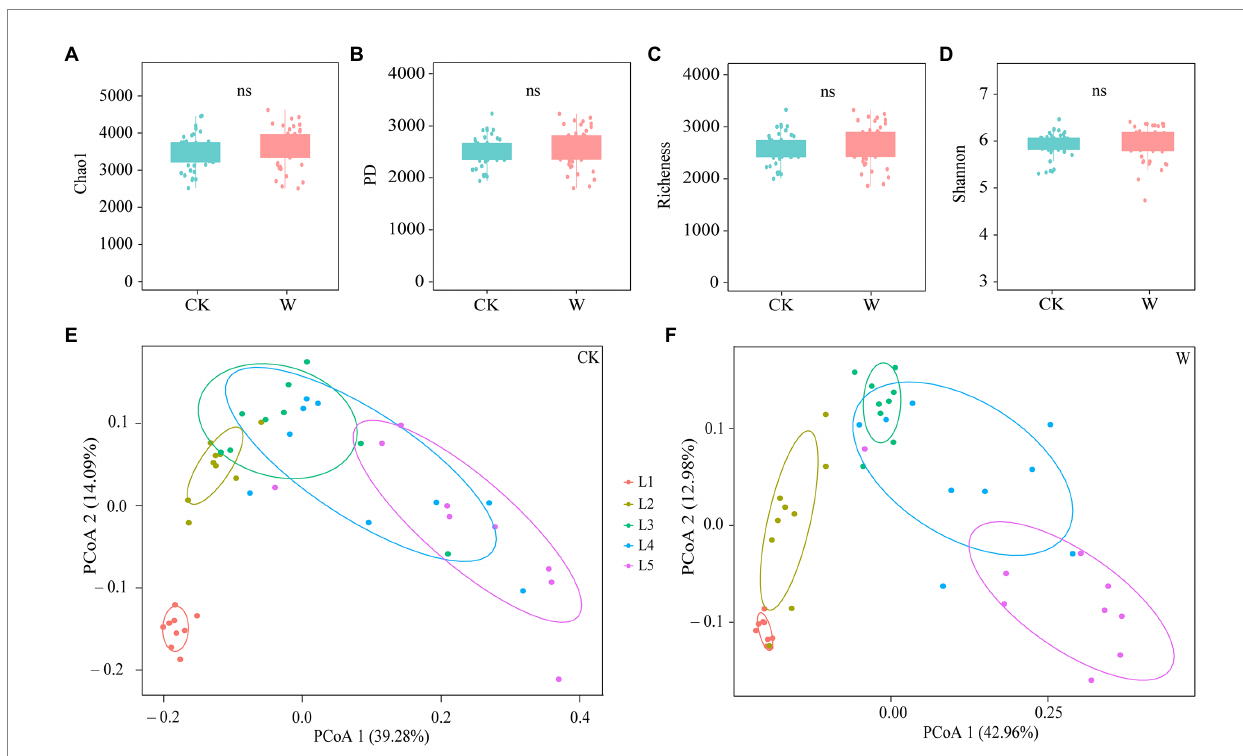
FIGURE 1 The bacterial diversity throughout the entire soil profile under control and warming. The α -diversity of bacteria between control and warming (using the Mann–Whitney U -test) (A–D) . PCoA analysis was performed on differences in community composition at different depths under control (E) and warming (F)